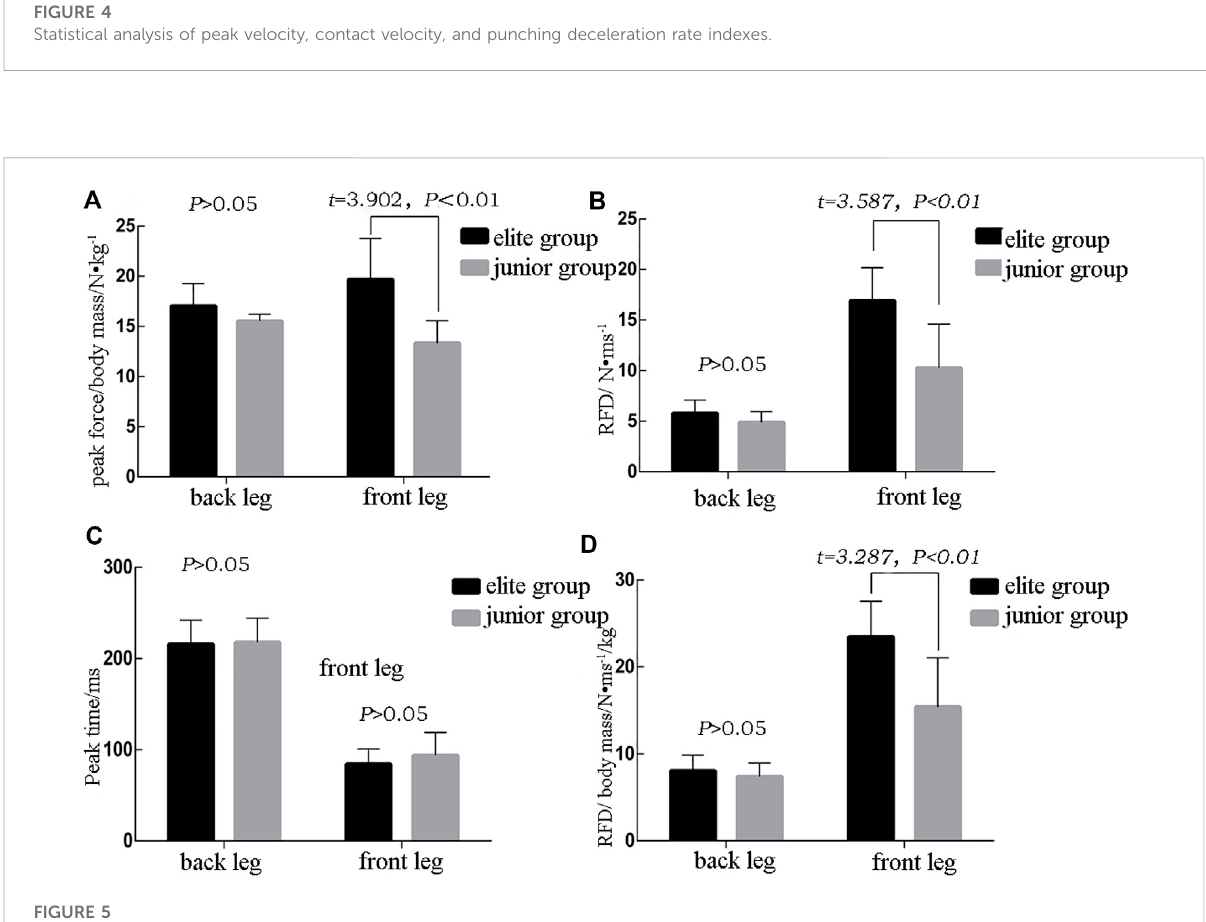
FIGURE 5 Analysis of force index results of lower